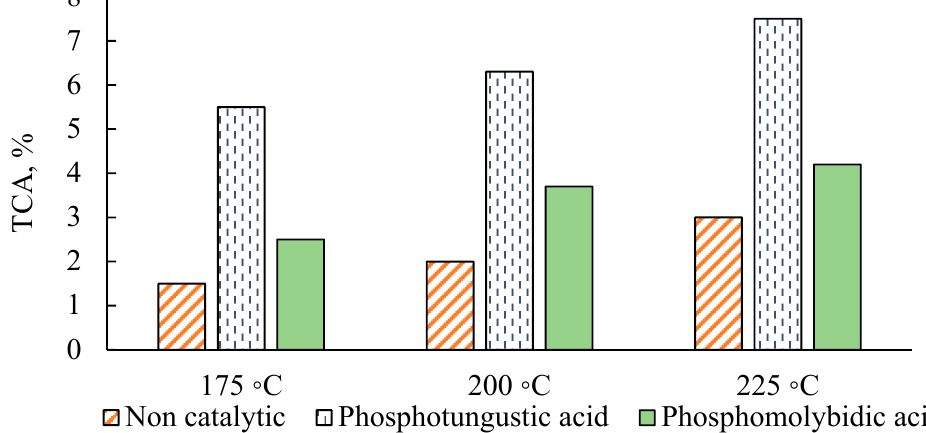
Figure 2. Effect of preheating and acid hydrolysis at 0 reaction time. The lignin:catalyst mass ratio for the catalytic experiments was 2:1 ( w / w ).